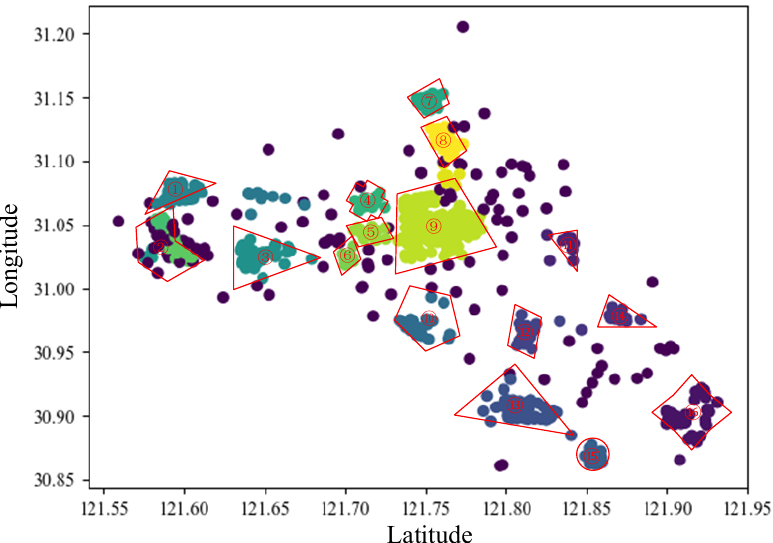
Figure 14. Fit clusters to regular images.